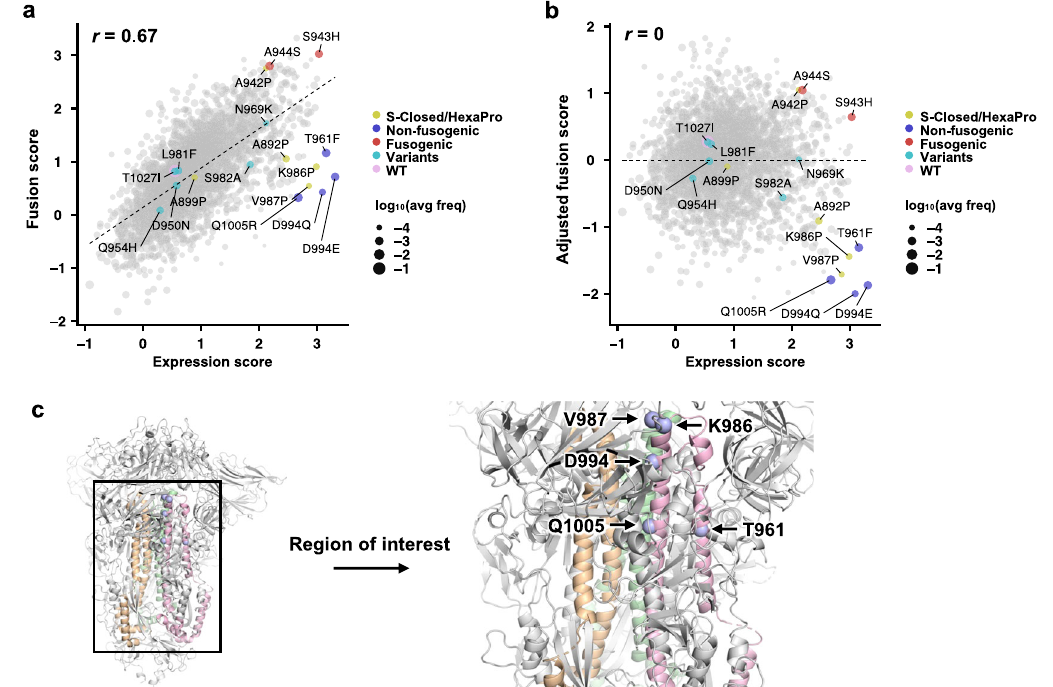
Fig.2|ExpressionandfusionscoresofindividualmutationsintheDMSlibrary. a Plot of fusion score against expression score for each mutant is shown. WT is indicated in pink. Mutations used in S-Closed 25 and/or HexaPro 24 are in yellow. Representative fusion-incompetent mutations identi fi ed in thisstudy are in purple (non-fusogenic). Representative mutations that enhance S fusogenicity are in red (fusogenic).MutationsfoundinmajorSARS-CoV-2variants(SupplementaryData1) are in teal (variants). Each data point represents one mutation in the DMS library.